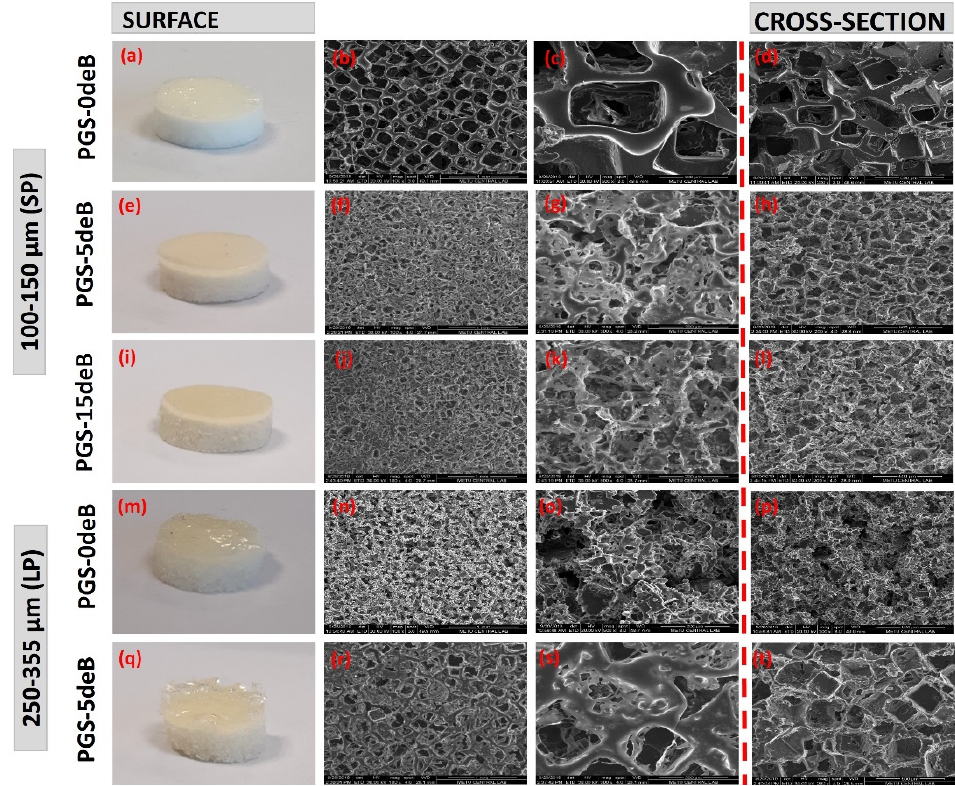
Figure 3. SEM micrographs of the PGS/deB blend scaffolds from the surface and cross-sectional areas. Please see the detail explanation of the subfigures ( a )–( t ) in the above paragraph. Table 2. Pore size, volume, weight ratios, and porosities of the PGS/deB scaffolds. Sample